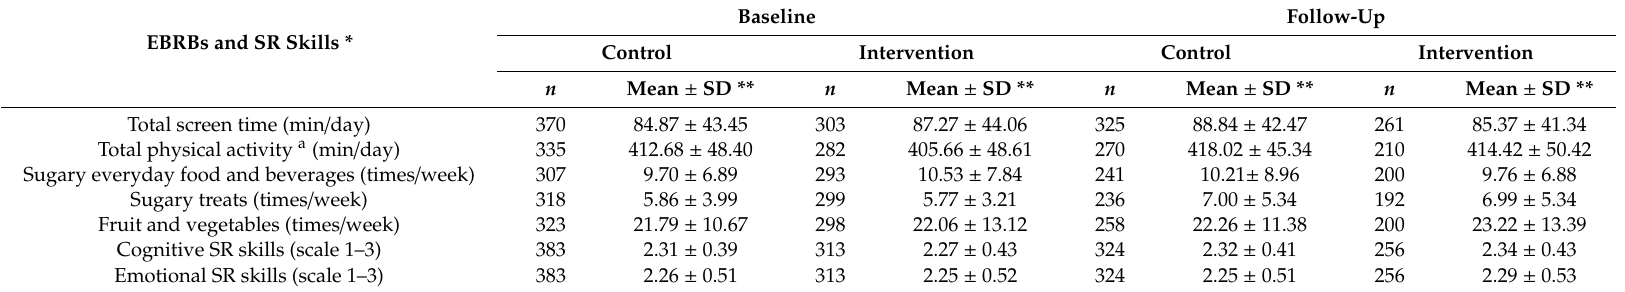
Table 2. Descriptors for children’s EBRBs and self-regulation skills by control and intervention group.